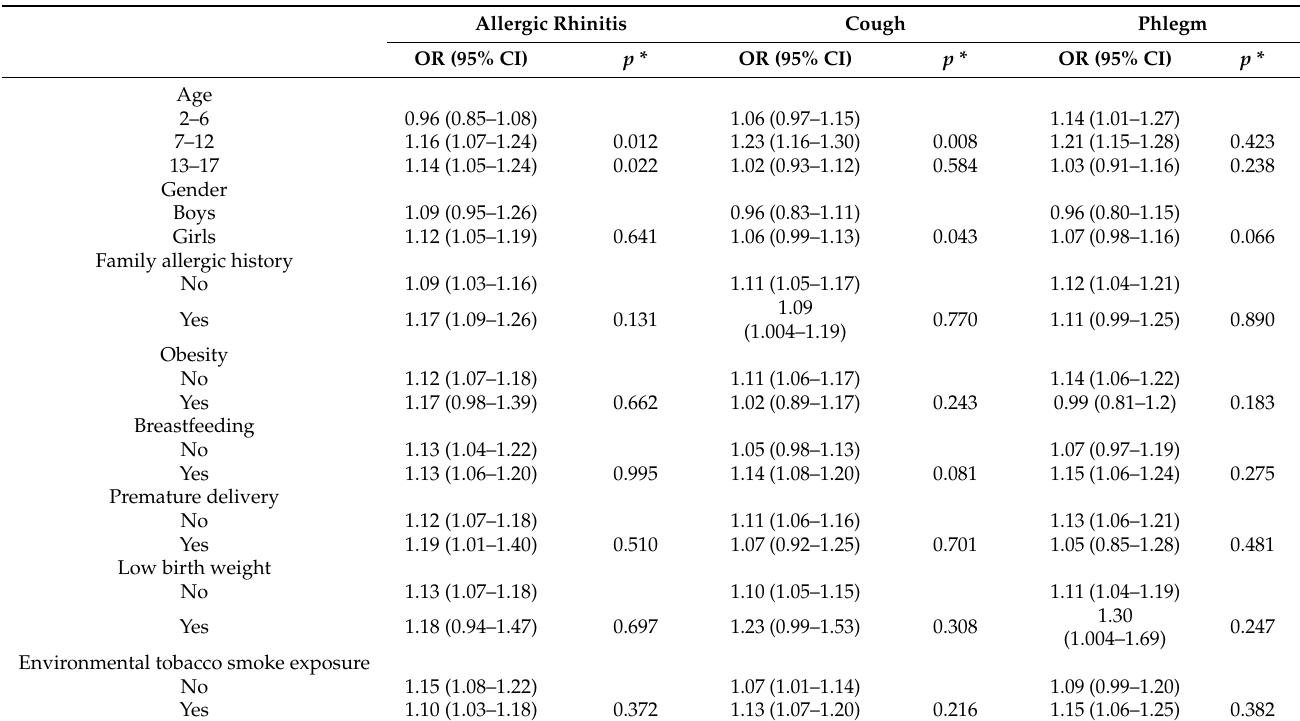
Table 3. Changes of AR, cough and phlegm associated with per IQR increment in O 3 exposure in interaction